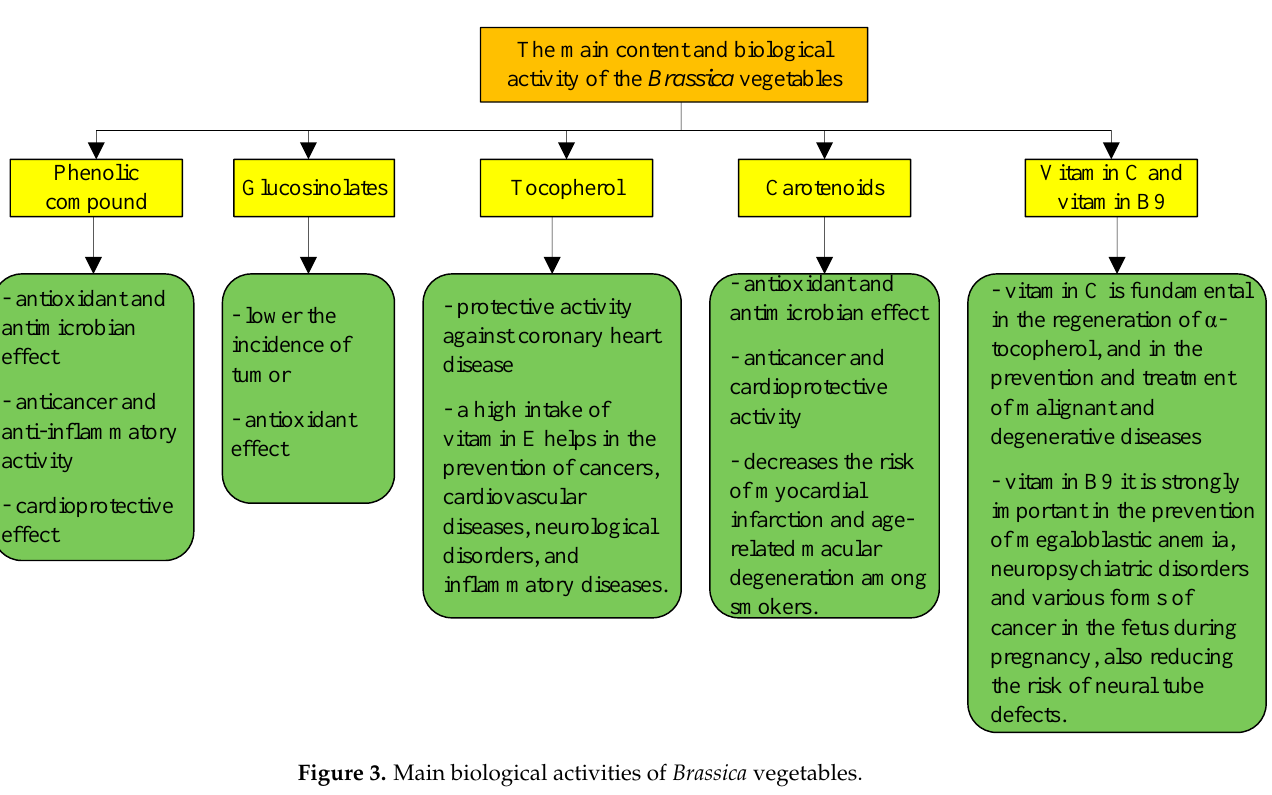
Figure 3. Main biological activities of Brassica vegetables.